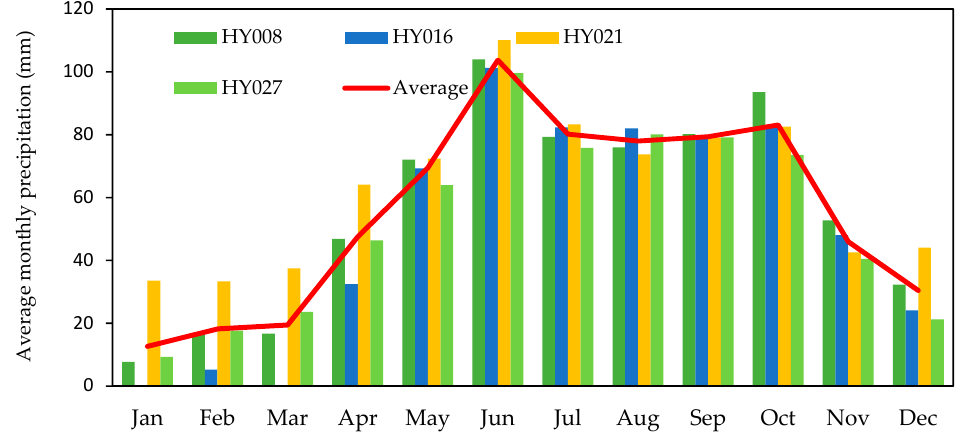
Figure 2. Average monthly precipitation in Toronto (from 2009 to 2016) for each of the four rain gauges (HY008, HY016, HY021, and HY027) used for this research. The location of each gauge within the study area is shown in Figure